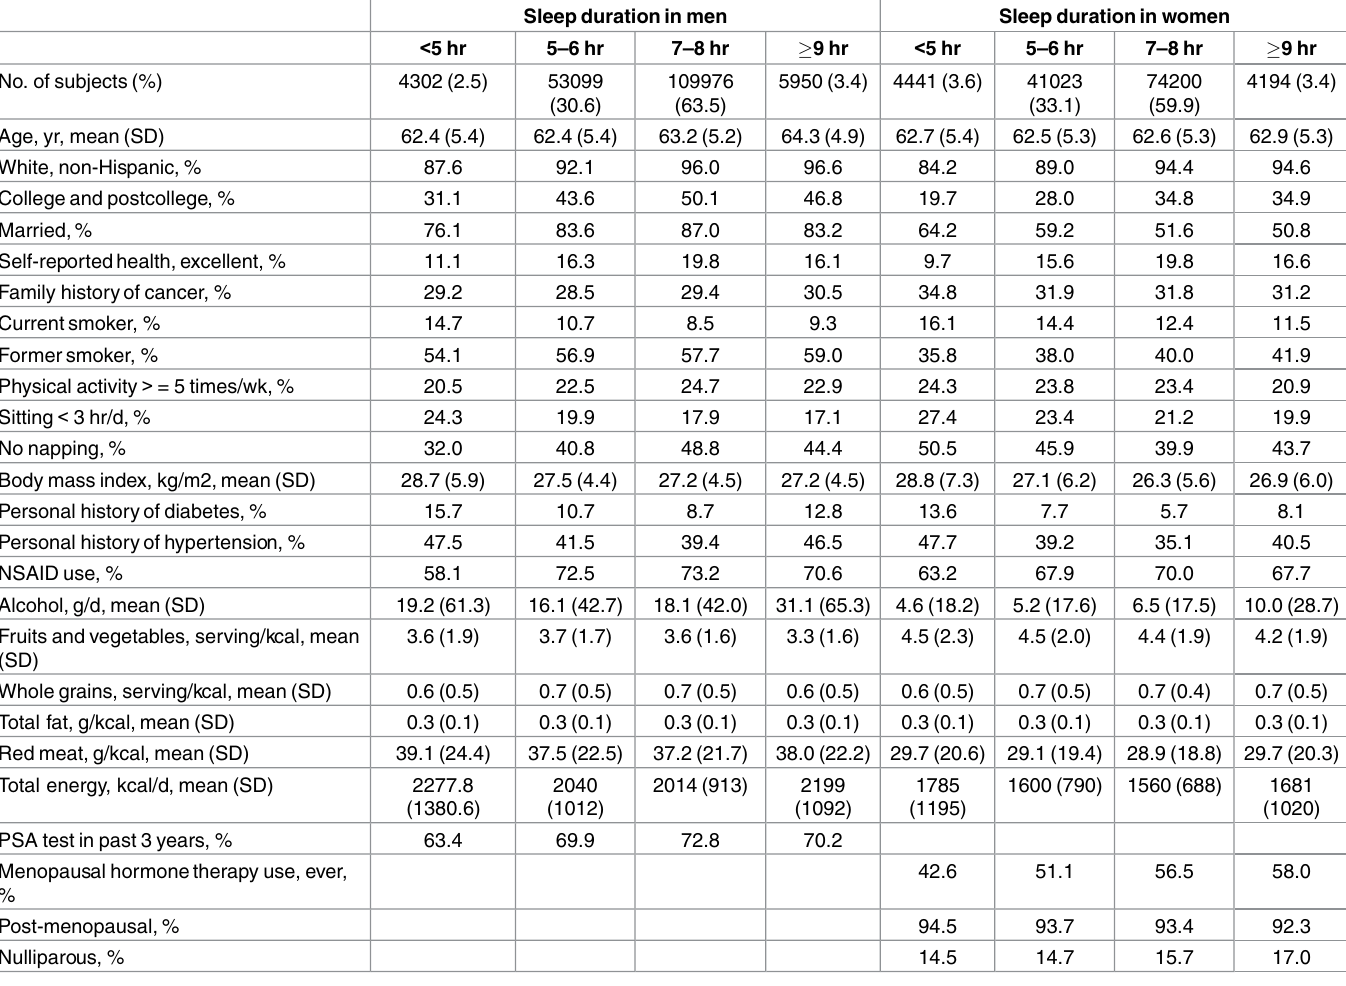
Table 1. Characteristics of study populationat baselineby sleepdurationin men and